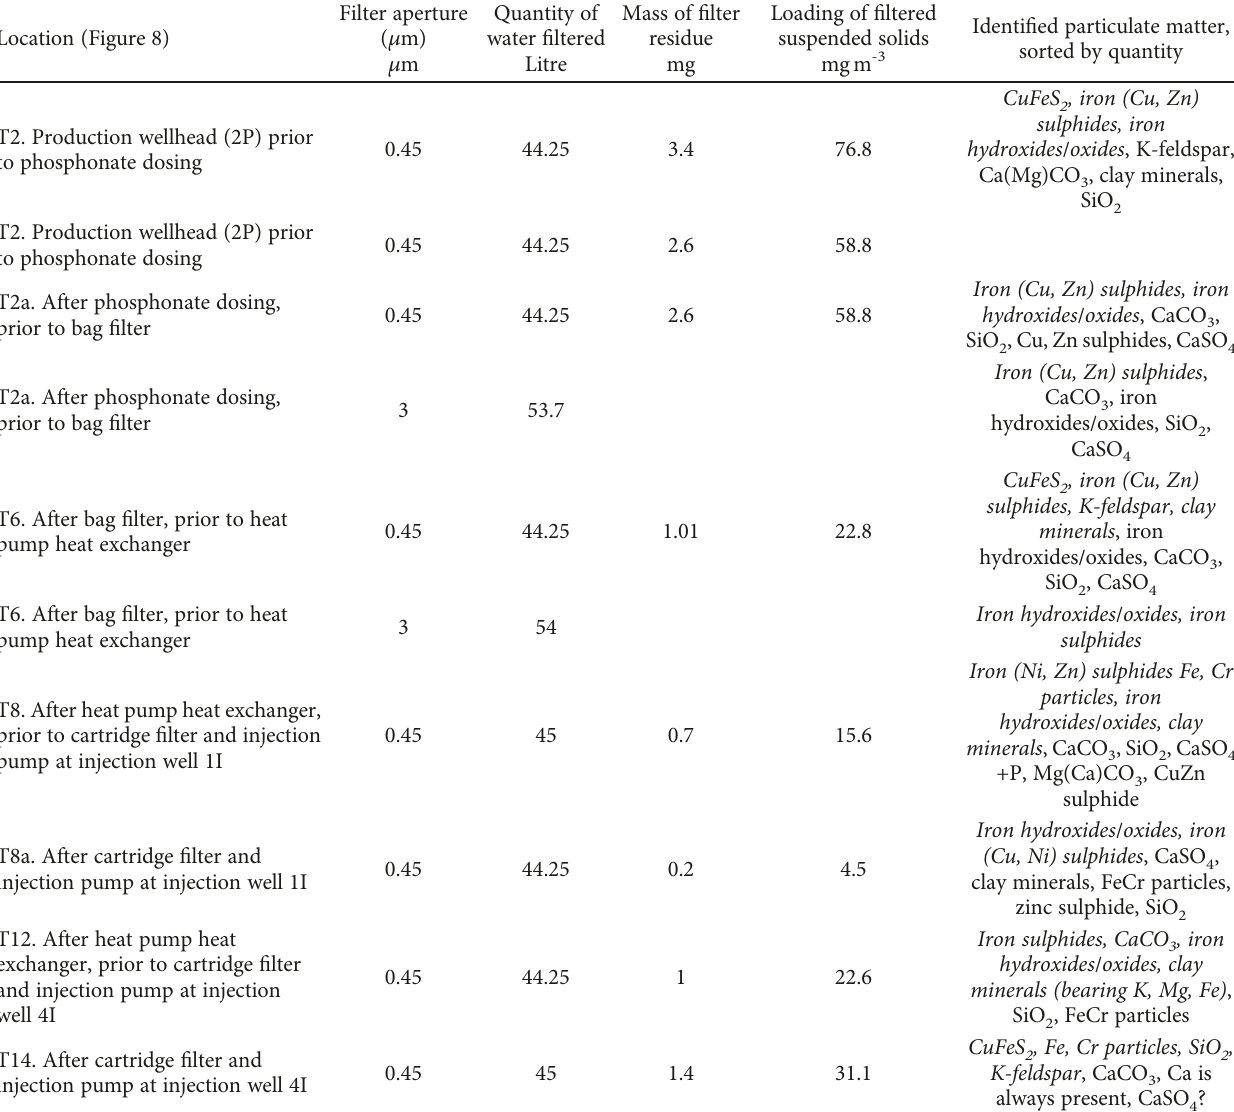
Location (Figure 8)